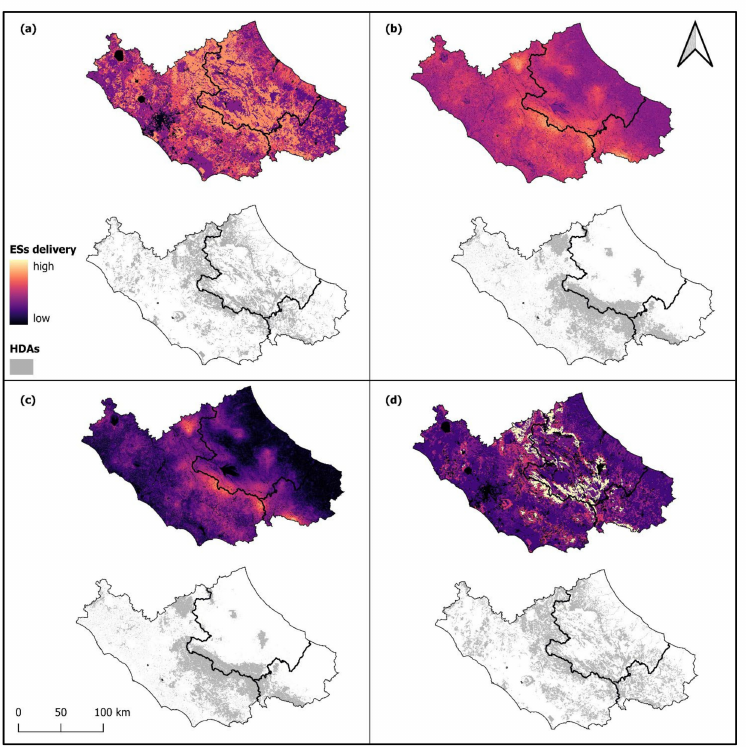
Figure 2. Ecosystem services’ delivery maps and high delivery areas (HDAs) for runoff retention ( a ), local recharge ( b ), baseflow ( c ), and carbon stock ( d ). Table 1. Pearson’s correlation coefficient for pairwise Ecosystem Services. n = 3,240,030. Runoff Baseflow Local Recharge